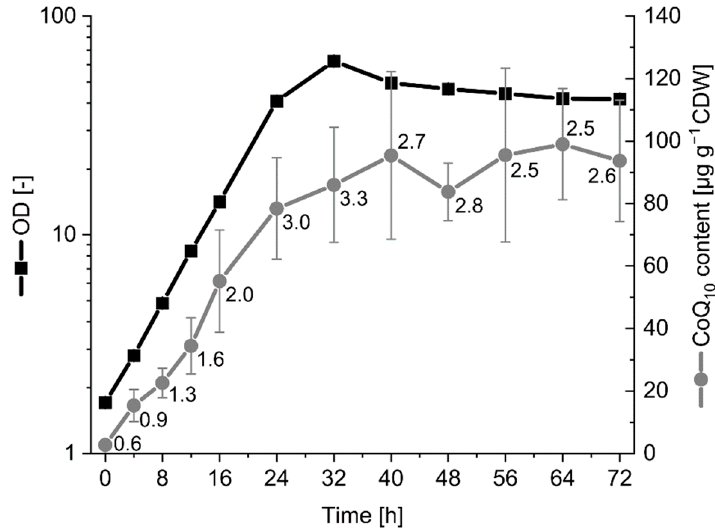
Figure 5. Growth and CoQ 10 content of UBI6-Rs from shake flask cultivation. The cultivation was performed independently from the cultivation represented in Table 3. The numbers next to the grey data points indicate the CoQ 10 /CoQ 11 ratios of relative peak areas from mass spectrometry analysis. Values and error bars represent means and standard deviations of 3 independent cultivations.